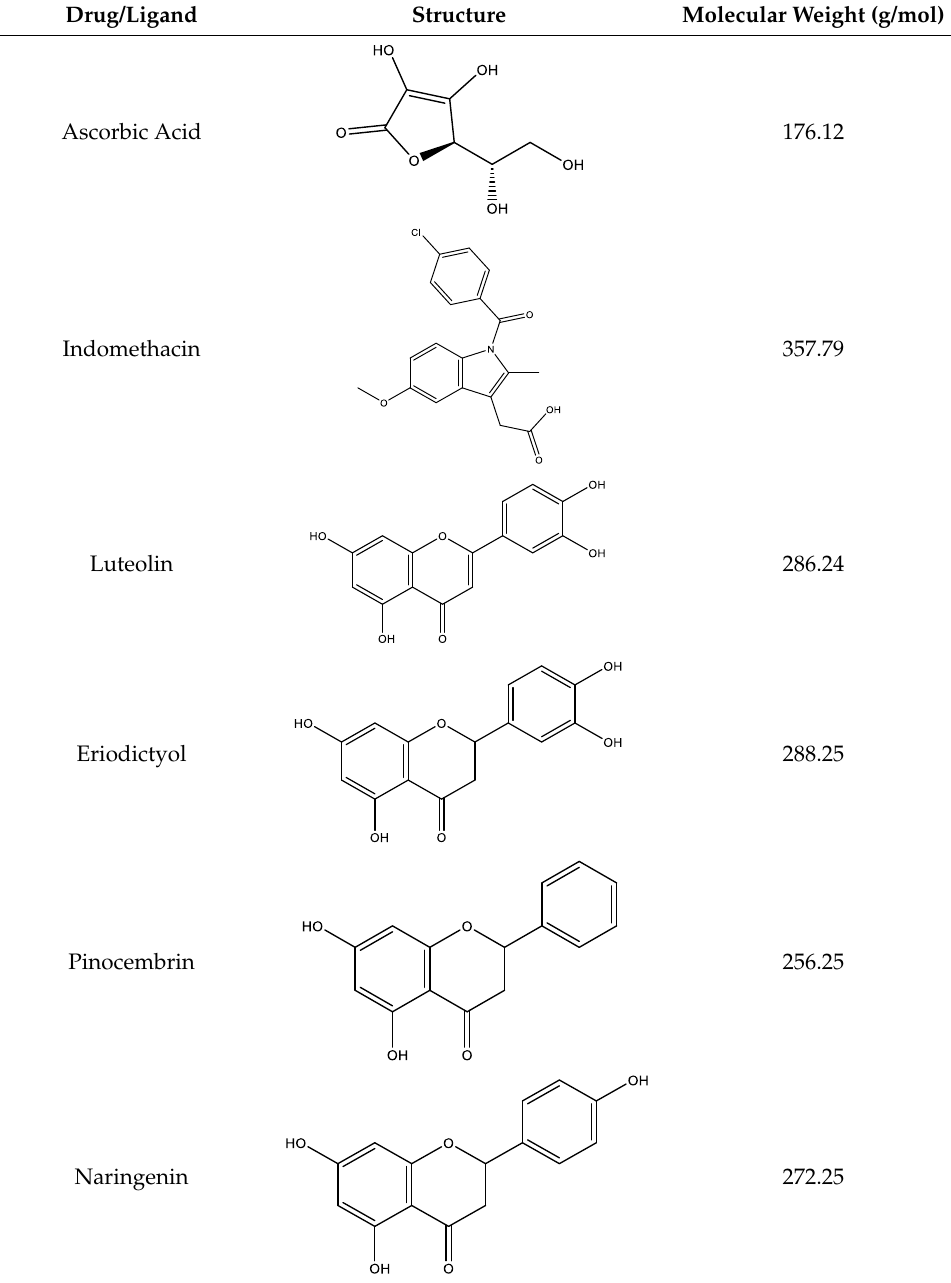
Table 3. Drugs and ligands used from C. cujete for antioxidant and anti-inflammatory properties [29].